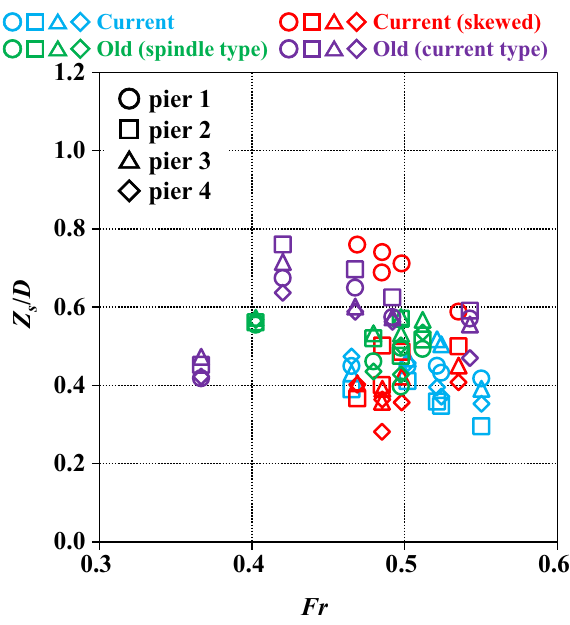
Figure 12. Relationship between maximum scour depth at pier perimeters and Froude number for the five